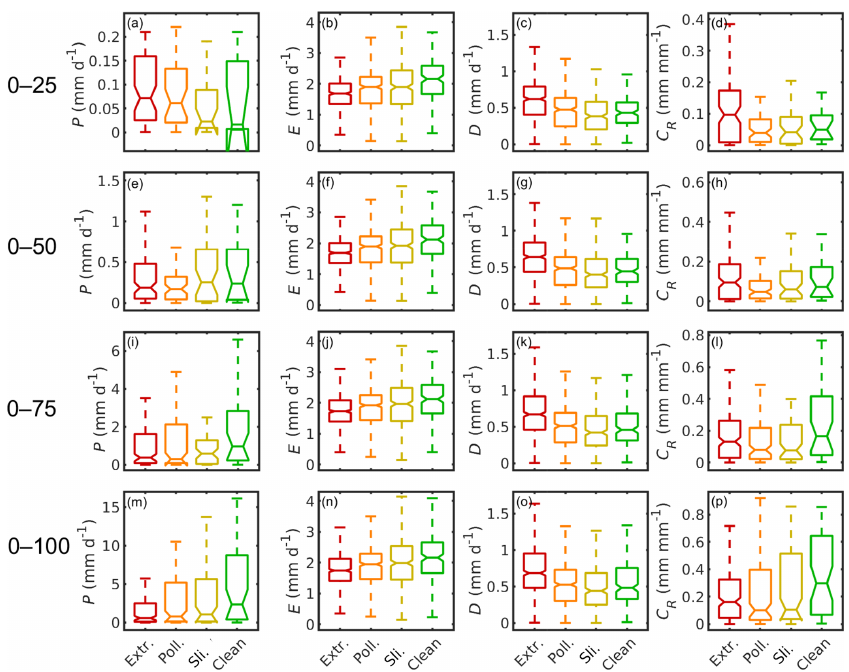
Figure 4. Box plots of daily precipitation ( P ), evapotranspiration ( E ), drainage ( D ), and runoff coefficient ( C R ) stratified by different pollution level (extremely polluted air, polluted air, slightly polluted air, and fairly clean air) and daily precipitation percentiles (rows) from low precipitation (0–25) to all precipitation events (0–100) for 2001–2013. The notches indicate the 95% confidence levels. Outliers are not shown. The amount of data used for each box is shown in Table 4. See “Statistical methods” for details.